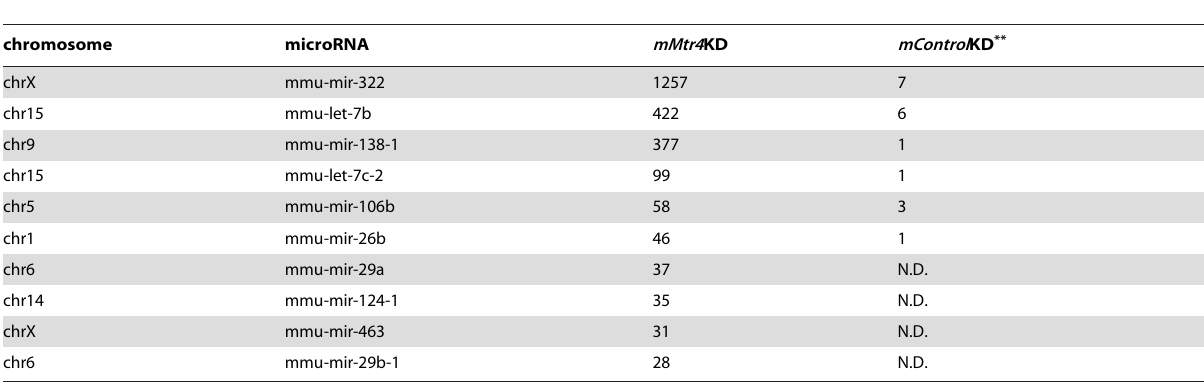
Table 3. Combined PA-seq data corresponding to miRNA 5 9 leaders (with $ 25